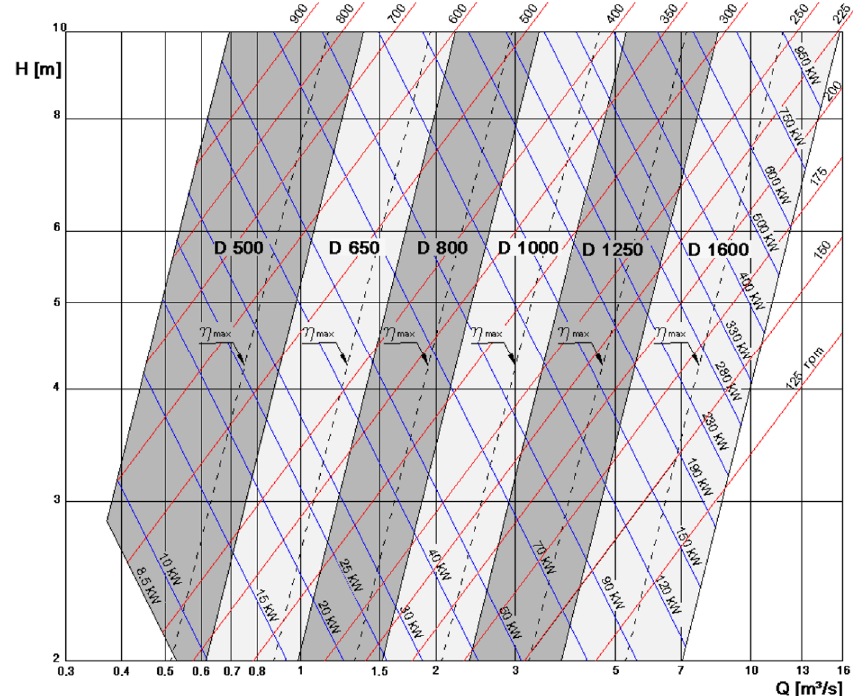
Figure 17. Nomogram of the series of four-blade semi-Kaplan turbines with non-classical spiral inflows on the runner.